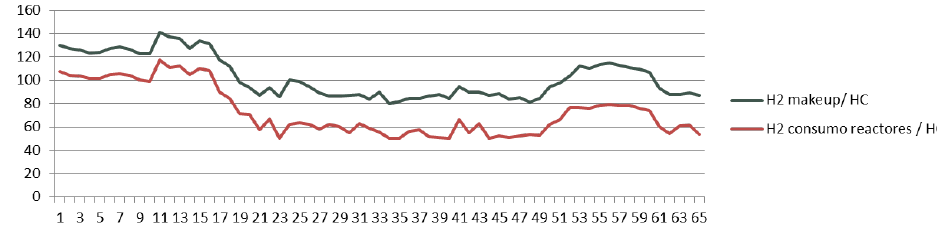
Figure 12. Two REIs showing specific use of hydrogen and specific hydrogen consumption in reactors of a HDS plant. Figures given in % of a certain scale.